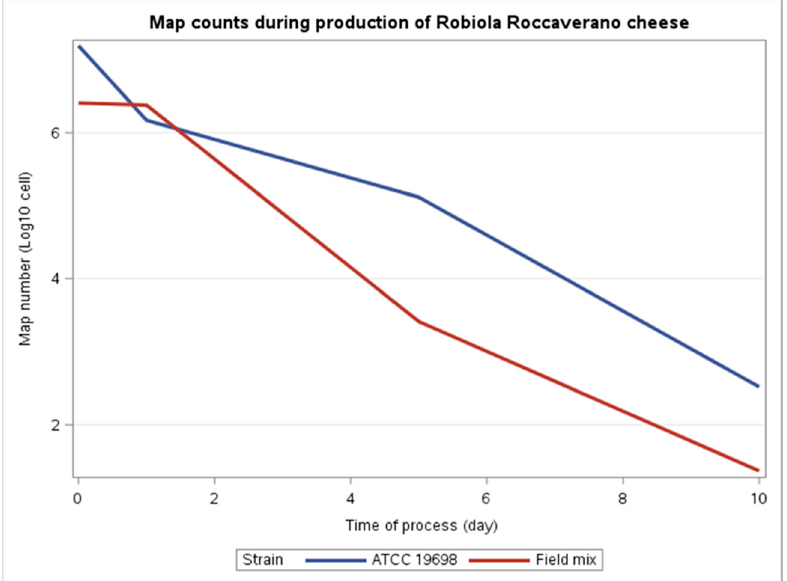
Figure 1. Variation of MAP count throughout the manufacturing and ripening of Robiola di Rocca- verano cheese production as estimated by qPCR for ATCC 19698 strain and field strain mixture.